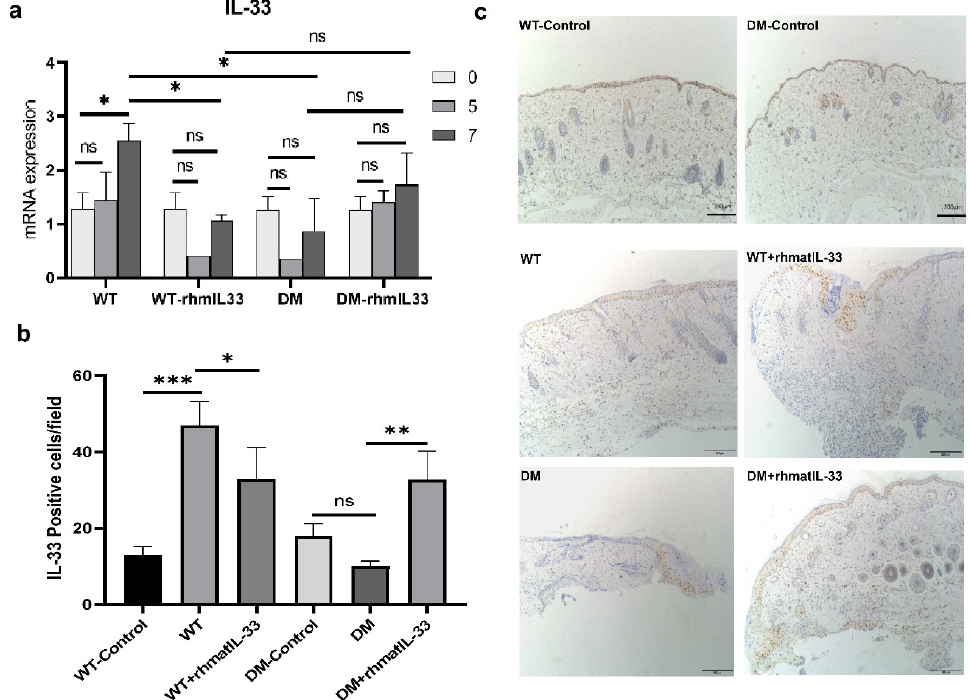
Figure 4. Expression of endogenous IL-33 in skin wounds. ( a ) Expression of the IL-33 mRNA in wound tissue at day 5 post-administration. ( b ) The number of IL-33 positive cells is presented in the form of a graph. * p , 0.05, ** p , 0.01, *** p , 0.001 and ns, not significant. ( c ) IL-33 immunohistochemical staining in the skin of